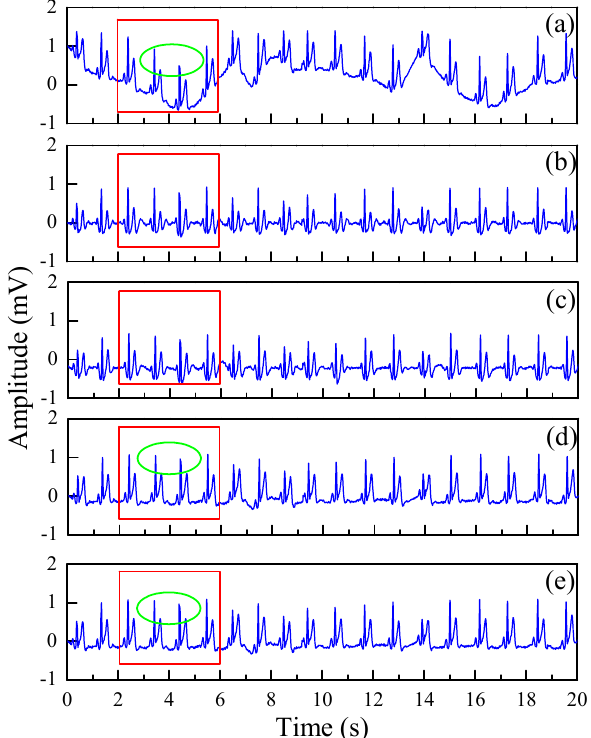
Figure 9. The results of different motion artifact removal methods for real ECG signals. ( a ) Original ECG signals; ( b ) DWT; ( c ) EMD; ( d ) EWT; ( e )EWT-WT.